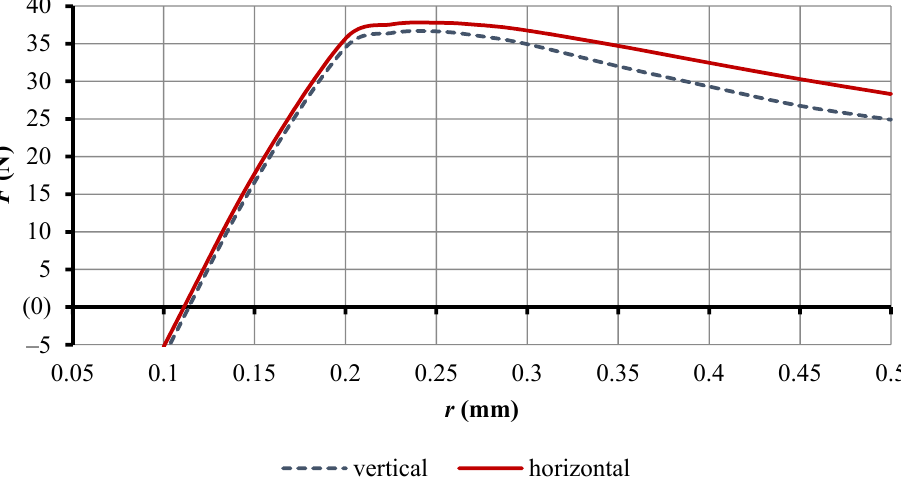
Figure 8. Influence of the gap between the BGD and the OM on the minimum lifting force at a pressure of p = 300 kPa.